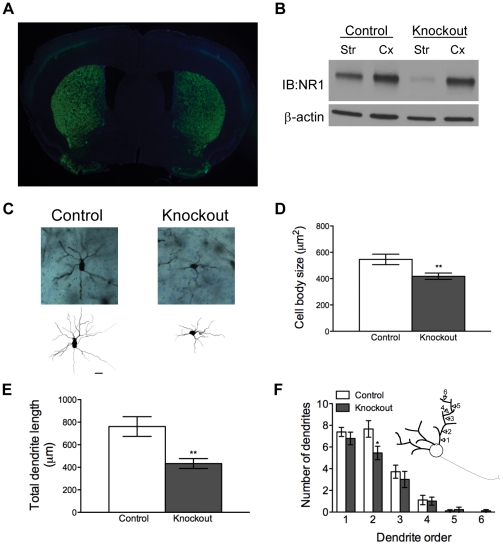
Knockout mice that selectively lack NMDAR in striatal MSNs have abnormal MSN morphology.
(A) GPR88-CreGFP is expressed selectively in the striatum of knockout animals. A DAPI counterstain was performed. (B) NR1 Western blot of striatal (str) and cortical (cx) homogenates from control and knockout animals. (C) Representative micrographs and tracings of MSNs from control and knockout animals (20 µm scale bar). (D) Cell body size of MSNs in control and knockout mice (n = 18 neurons per genotype); P = 0.009 by unpaired t test; **P<0.01. (E) Total MSN dendrite length in control and knockout mice (n = 18 neurons per genotype); P = 0.002 by unpaired t test; **P<0.01. (F) Number of dendrites by dendrite order in control and knockout mice (n = 18 neurons per genotype); *P<0.05 by unpaired t test. Diagram in (F) depicts the definition of dendrite order.